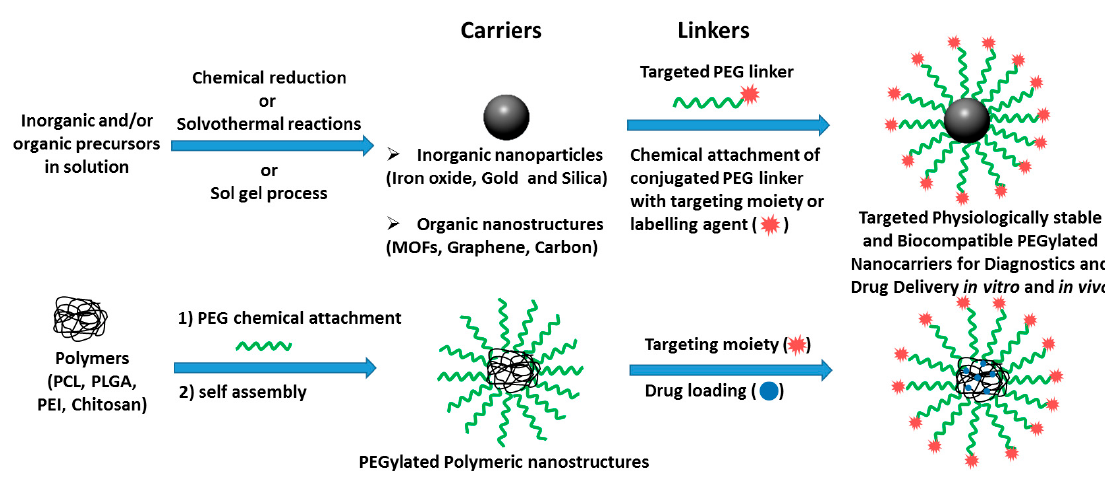
Figure 1. Nano particulate delivery designs discussed in this review.